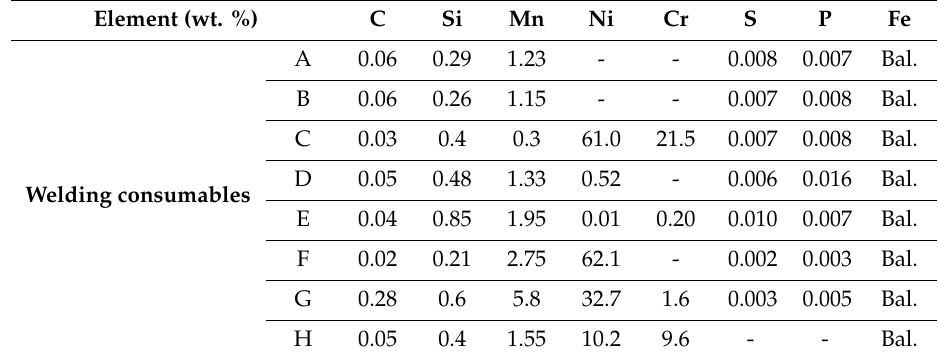
Table 4. Chemical composition of each welding consumable.